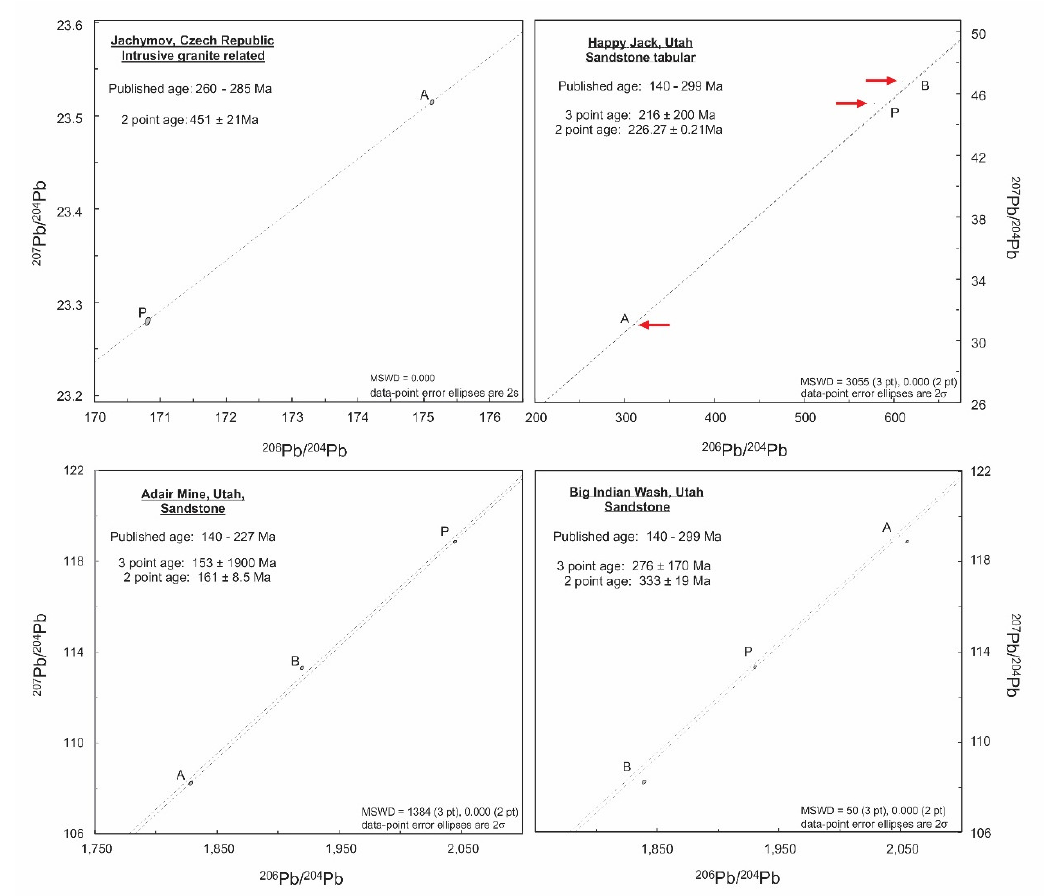
Figure 6. Secondary Pb–Pb isochron for Jachymov ( A ) the intrusive granite related sample and the three sandstone type related samples, ( B–D ) Symbol size (including associated uncertainty) for certain analyses are difficult to see, due to large range (scaling) of Pb isotope compositions. Therefore, a red arrow is shown to indicate the position of these analyses.